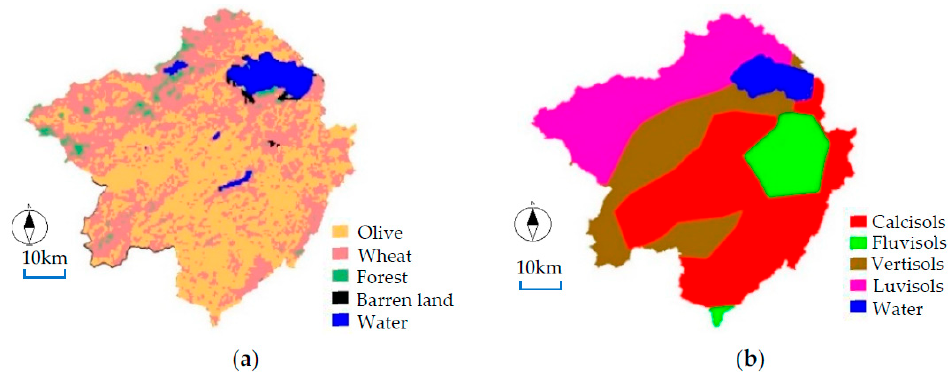
Figure 4. ( a ) Land use distribution and ( b ) Soil map of the catchments.